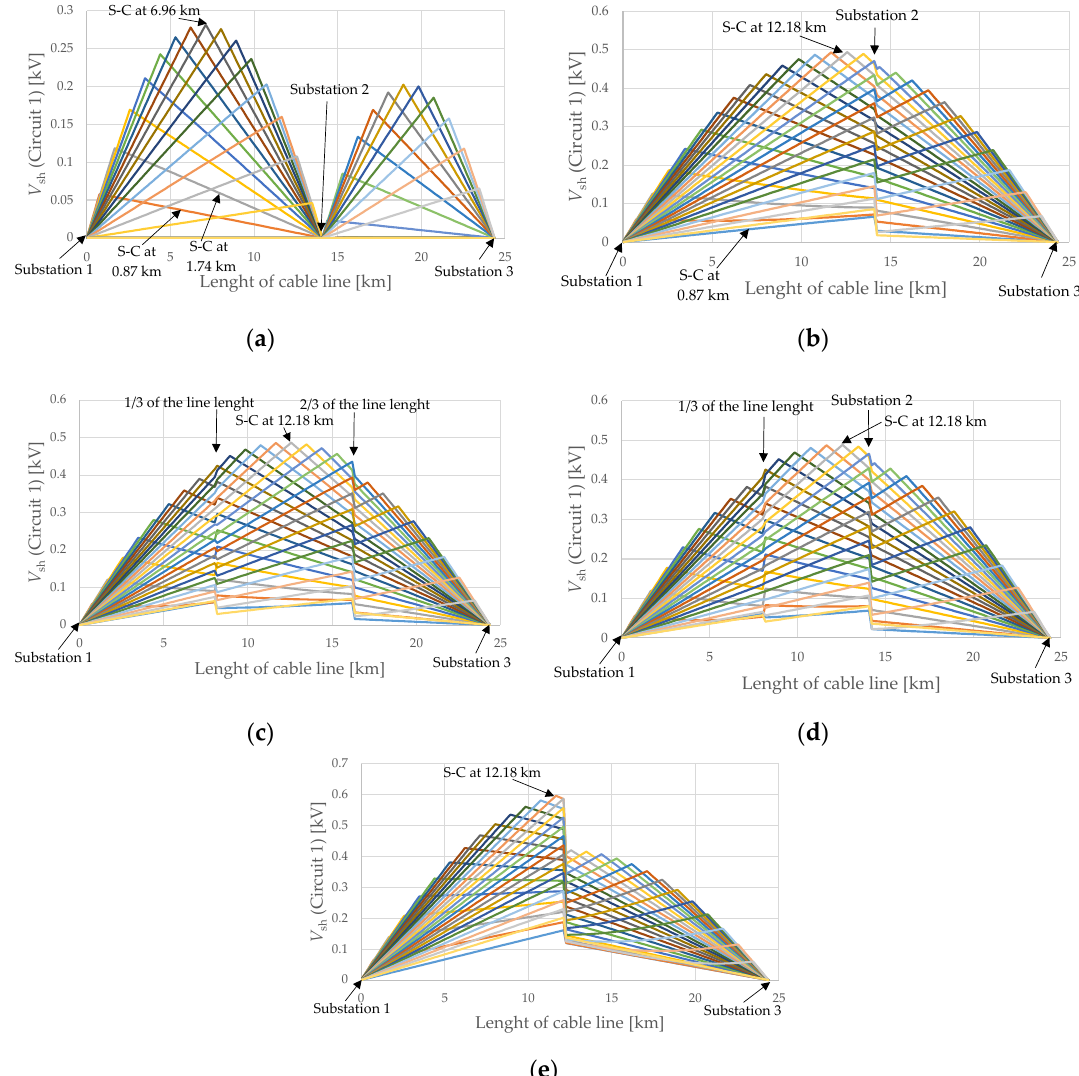
Figure 26. Line-to-earth short-circuit for various of cable sheaths crossings: ( a ) sheaths bonded and earthed in Substation 1, 2 and3; ( b ) sheaths cross-bonding in Substation 2; ( c ) sheaths cross-bonding in 1/3 and 2/3 of the line length; ( d ) sheaths cross-bonding in 1/3 of the line length and in Substation 2; ( e ) sheaths cross-bonding in 1/2 of the line length.